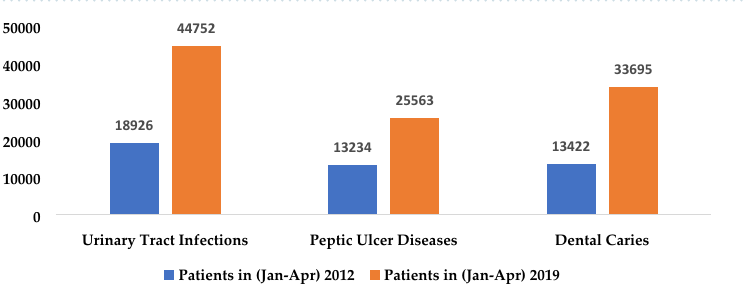
Figure 7. Calcium hardness of groundwater of the 2 years (2012 and 2019).